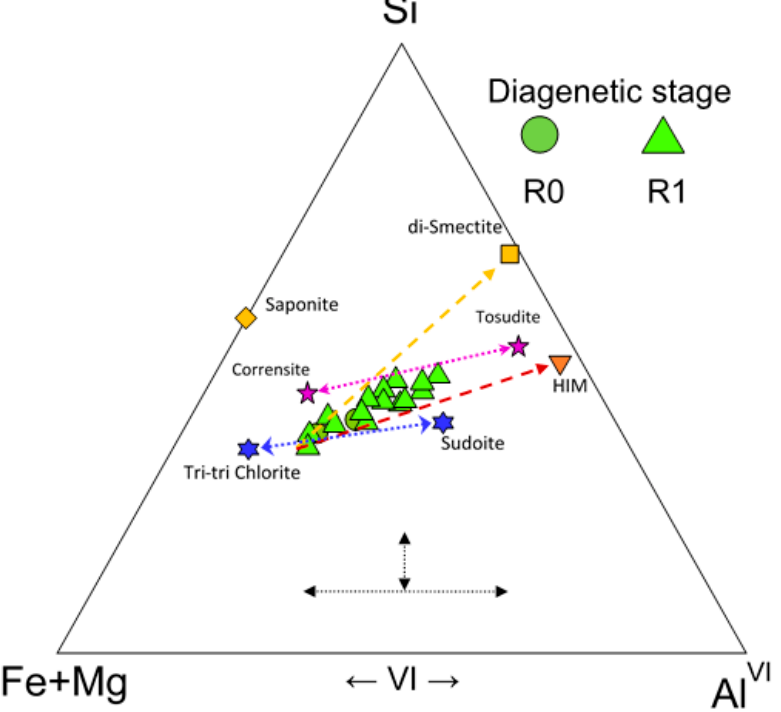
Figure 9. Compositional plot of the chlorite phases in the ternary diagram of Si - R 2+ - R 3+ . The arrows denote possible vectors accounting for the compositional ranges determined by AEM.